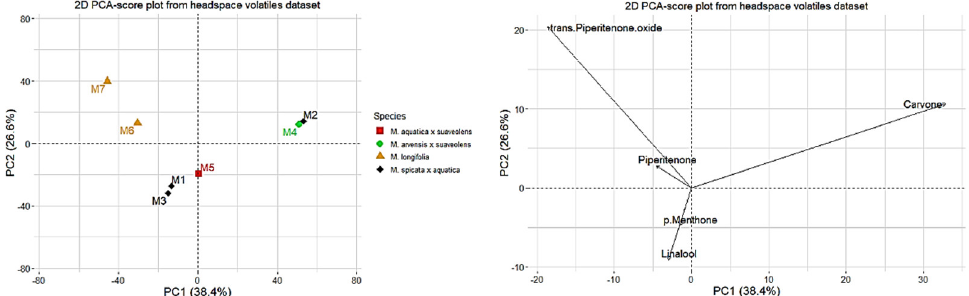
Figure 4. Principal component analysis (PCA) scores ( left ) and loadings ( right ) (only first five variables with the highest contributions are shown) plots based on headspace volatiles dataset.